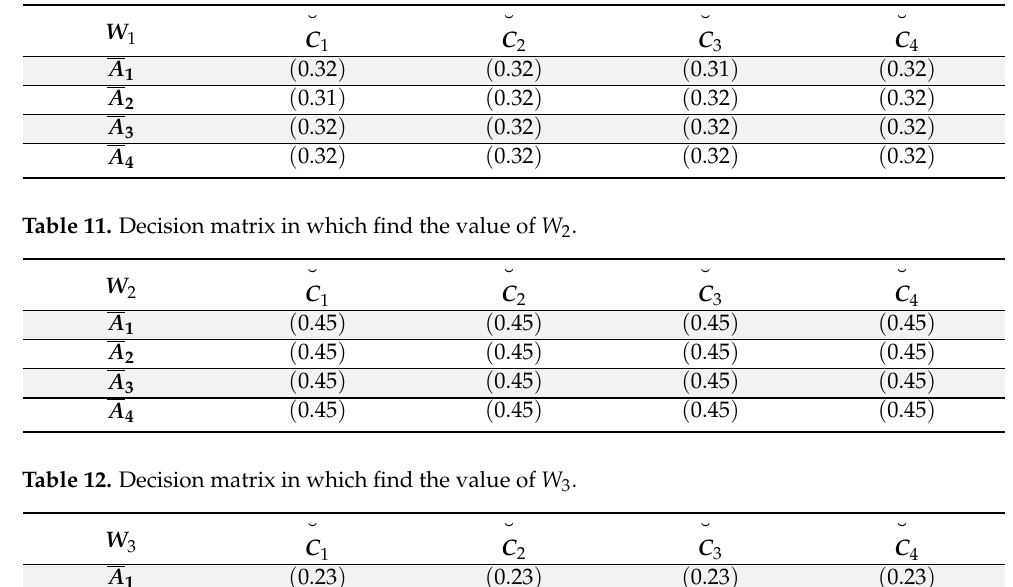
Table 10. Decision matrix in which find the value of W 1 .